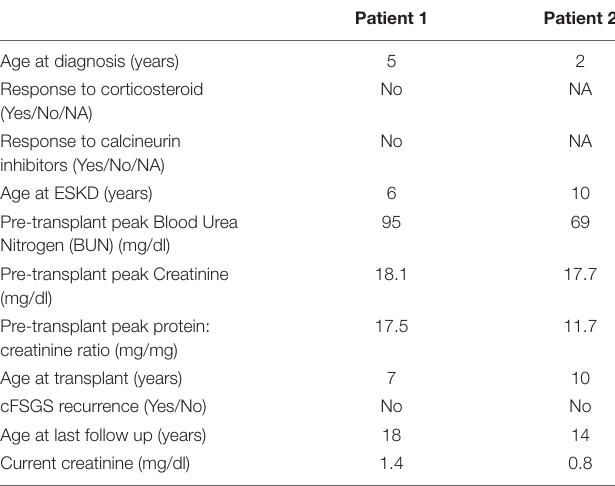
TABLE 1 | Clinical characteristics of siblings with NUP93